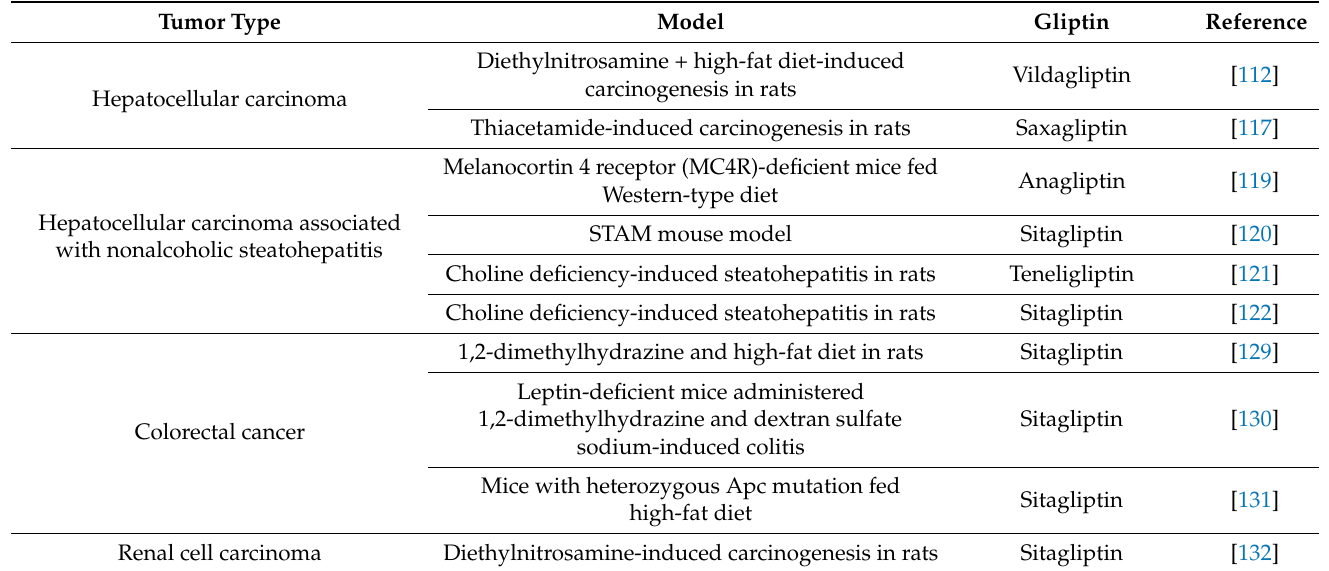
Table 3. Summary of preclinical studies demonstrating possible chemopreventive effects of